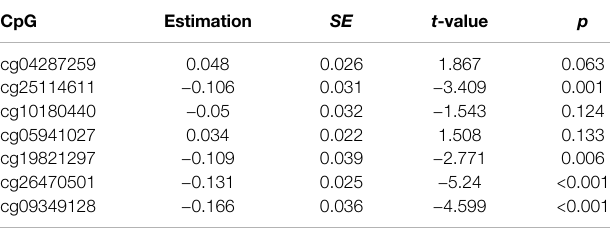
TABLE 4 | The estimation effect of smoking.